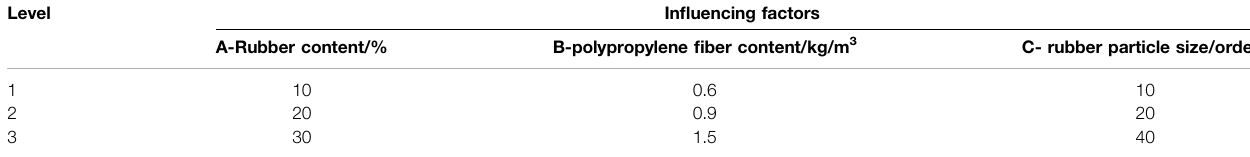
TABLE 4 | Factor levels of orthogonal test.